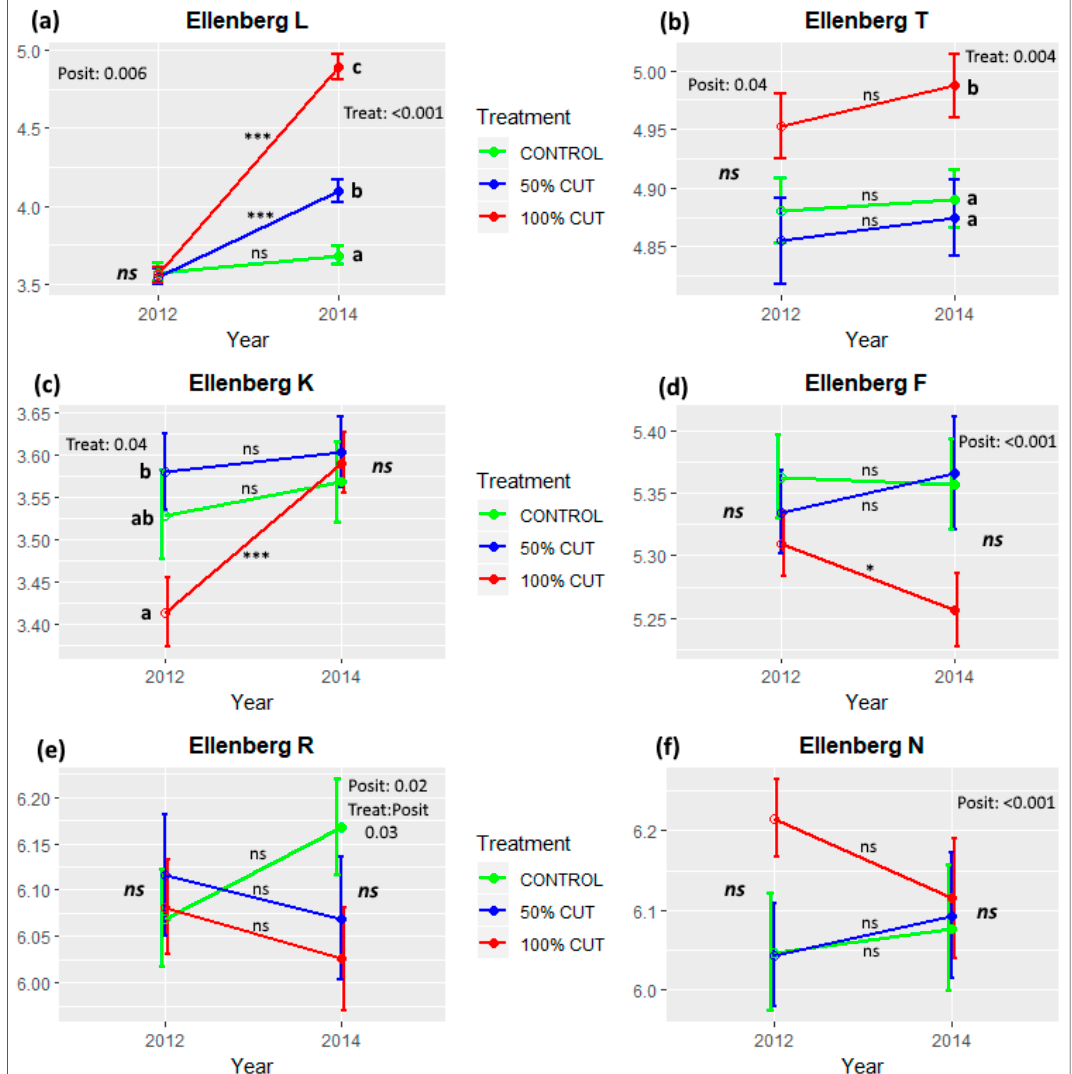
Figure 5. Plot-level Ellenberg indicator values (EIVs) for different cutting treatments (control, 50% cut, 100% cut) in 2012 (before cutting) and in 2014 (after cutting). ( a ) L = light, ( b ) T = temperature, ( c ) K = continentality, ( d ) F = moisture, ( e ) R = reaction, and ( f ) N = nutrients. Error bars represent standard error. Inside each of the six panels, the significant effects of fixed factors (Treat = treatment, Posit = within-sinkhole position) are reported (i.e., p values from mixed-effect models): on the left side for the year 2012 and on the right side for the year 2014. Letters in bold denote significant differences between pre- and post-treatment intensities and “ns” stands for non-significant differences between treatments. Changes from pre- to post-disturbance values are indicated by “ns” or asterisks (* p < 0.05, ** p < 0.01, *** p < 0.001) in the middle of each panel, close to the line that connects the two error